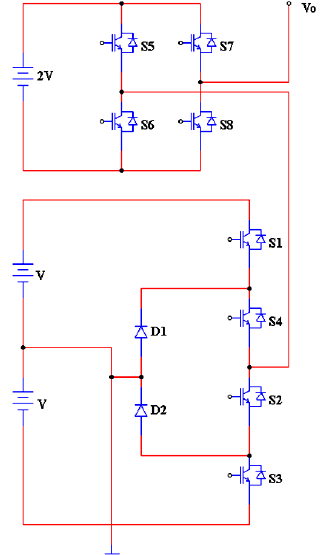
Figure 25. Novel reduced switch MLI.